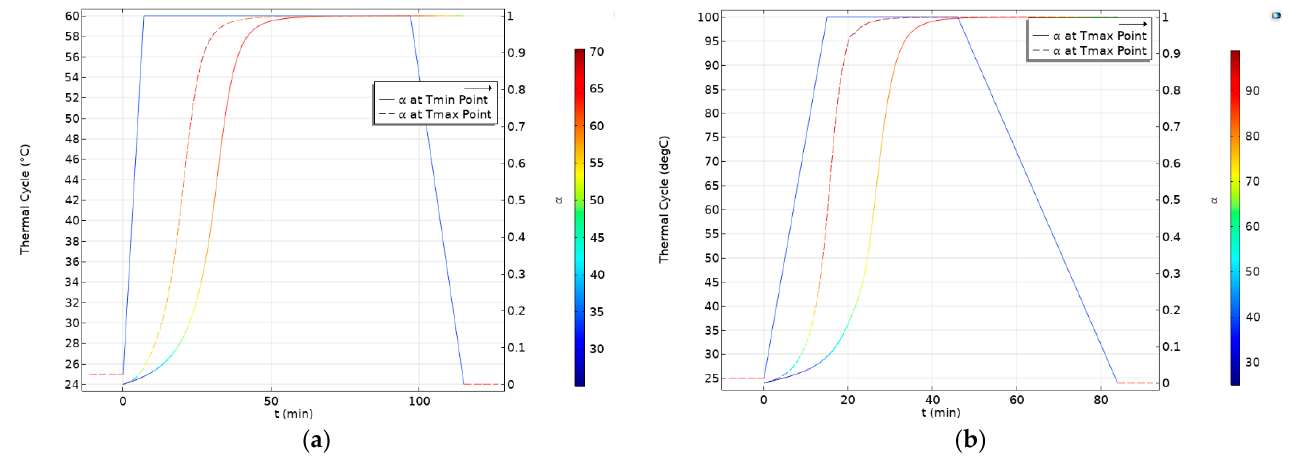
Figure 11 . Thermal cycle vs. α (DoP) for the curing cycle at 60 °C ( a ) and 100 °C ( b ).